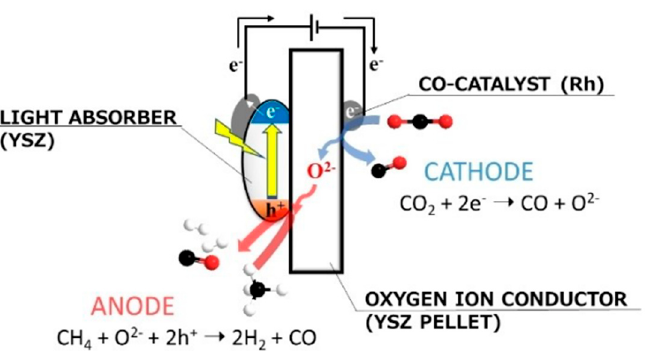
Figure 41. Speculated mechanism illustrated from the obtained results. Reprinted from [52]. Copy-